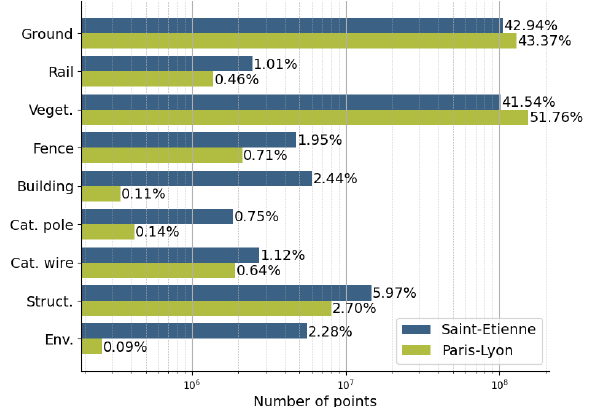
Figure 3. Number of points per class (and percentages) for each of the railway